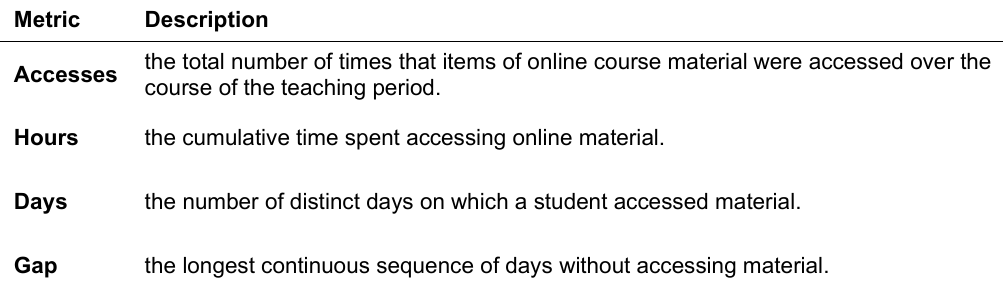
Table 3. Metrics of online engagement